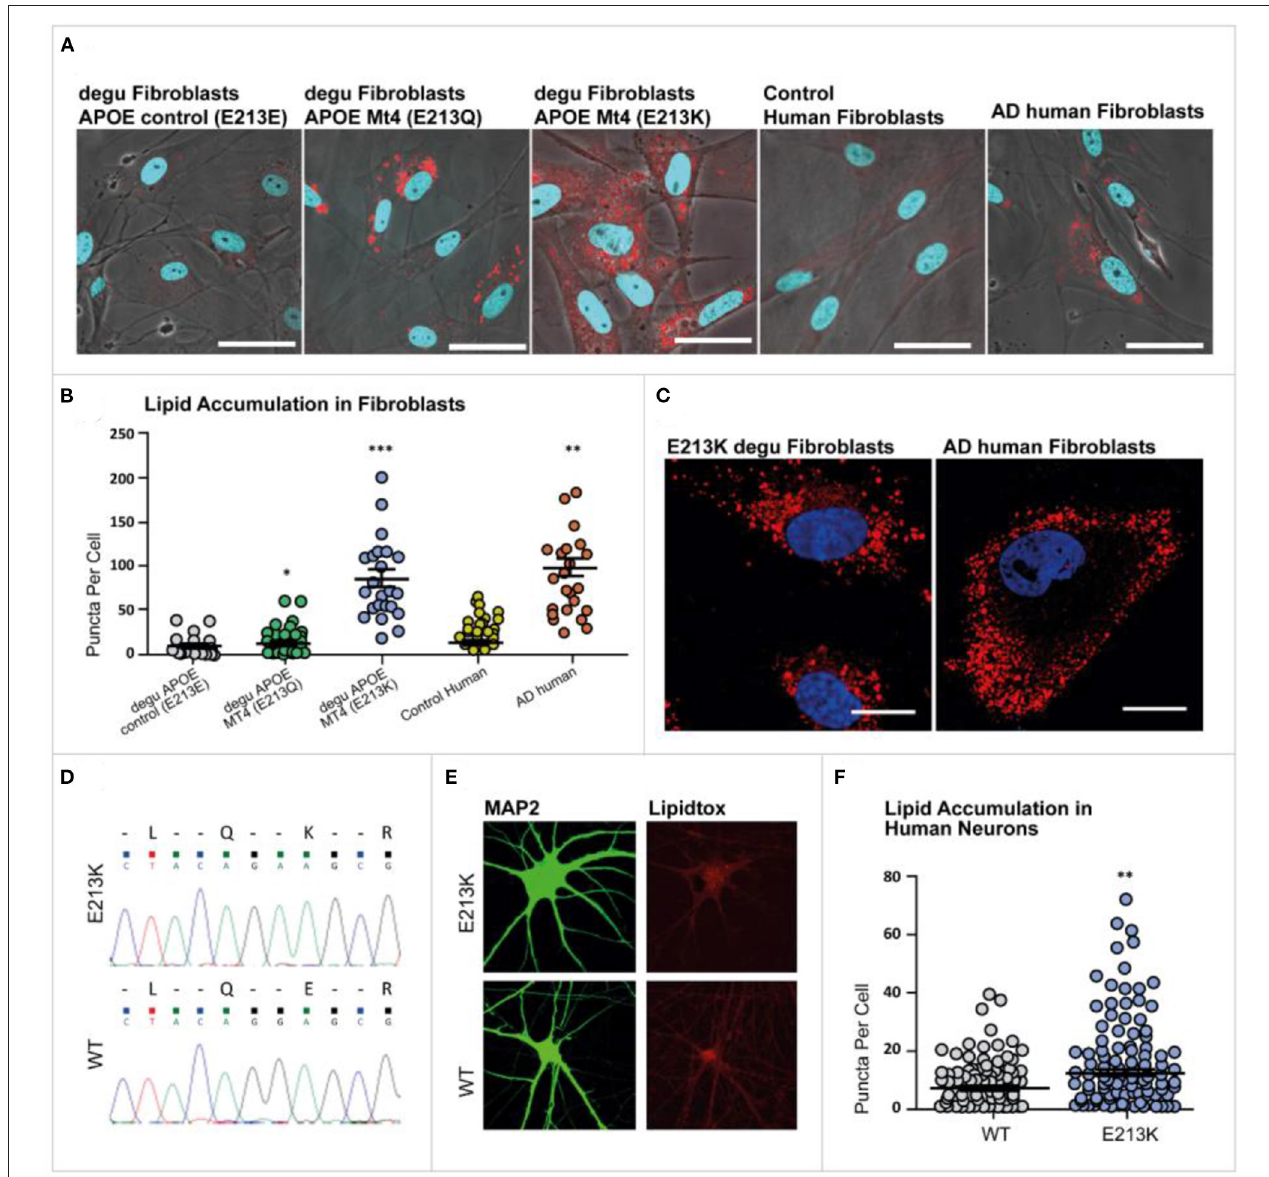
FIGURE 7 | Lipid droplet accumulation in degu and human fibroblasts. Primary cultures of degu and human fibroblasts stained with LipidTOX TM Red Neutral Lipid stain (red), where nuclei were identified through DAPI counterstaining (blue). (A) Representative micrographs of E213E, E213Q, and E213K degu fibroblasts, as well as fibroblasts obtained from human controls and patients with AD. (B) Lipid droplet quantification in degu and human fibroblasts. (C) Representative images of E213K degu fibroblasts and fibroblasts from patients with AD showing prominent lipid droplet accumulation. (D) Heterozygous mutant cell line confirmed through Sanger sequencing. (E) Neurons were stained using MAP2 and lipid accumulation was visualized with LipidTOX TM . (F) Compared with neurons derived from isogenic controls, neurons derived for degu and humans carrying od Apoe Mt4 E213Q and E223K, respectively, showed a significant increase in lipid puncta ( P = 0.0095, Student’s t -test, n = 124). od Apoe Mt4 and wild-type neurons derived from two independent cultures. The scale bar represents 20 µ